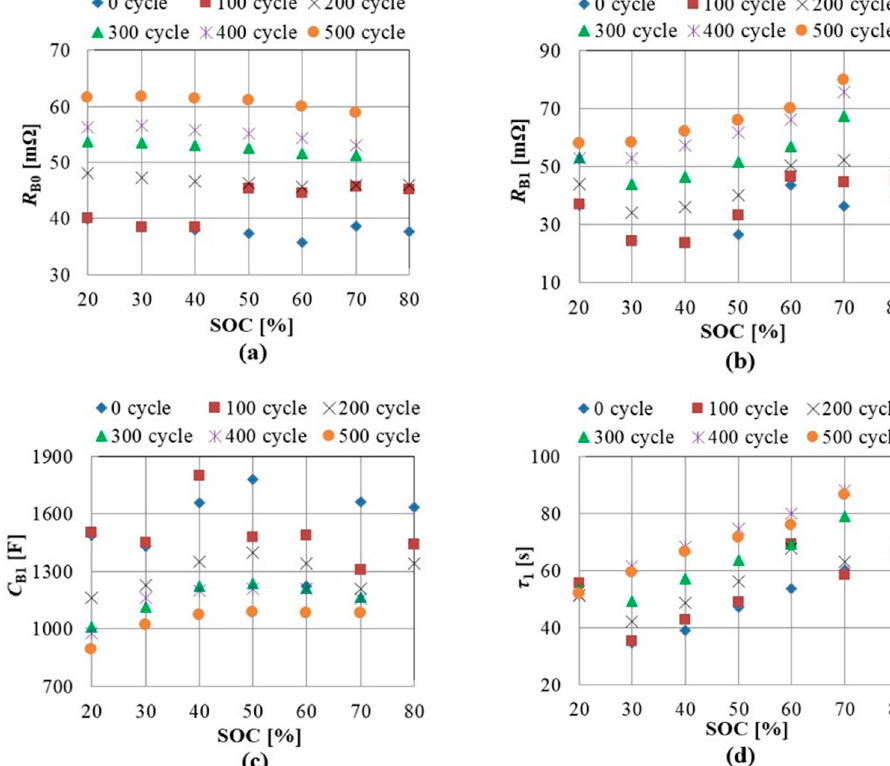
Figure 8. SOC dependence of equivalent circuit parameters. ( a ) R B0 . ( b ) R B1 . ( c ) C B1 . ( d ) τ 1 .